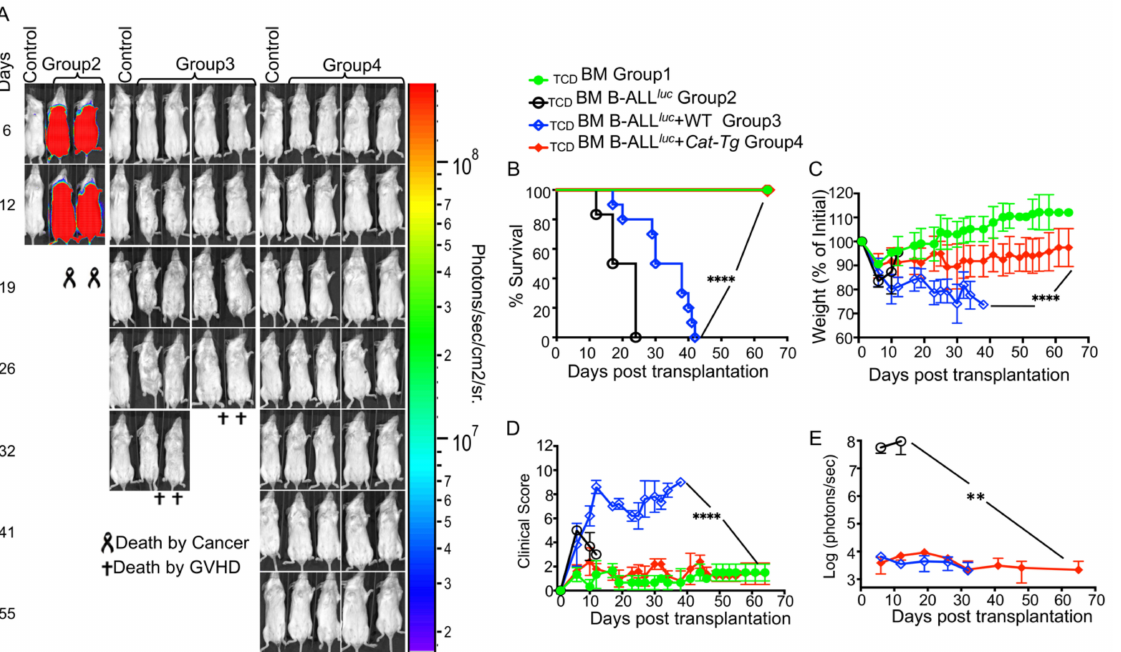
Figure 1. Wnt/ β -catenin overexpression in T cells results in retention of GVL effect but avoids GVHD during allo-HSCT. 1 10 6 purified WT or Cat-Tg CD3+ T cells were transplanted into lethally irradiated BALB/c recipient mice, along with × 1 10 7 T cell-depleted bone marrow cells from WT mice and 1 10 5 B-ALL- luc cells. Host BALB/c mice were imaged using × × the IVIS50 system 3 times a week. Group 1 received T cell-depleted bone marrow only (labeled as TCD BM). Group 2 received 1 10 7 TCD BM from WT mice and 1 10 5 B-ALL- luc cells ( TCD BM+B-ALL luc + ). Group 3 was transplanted with 1 10 7 × × × 6 purified WT CD3 + T cells, along with 1 10 5 B-ALL luc + cells ( TCD BM+B-ALL luc + WT). TCD BM from WT mice and 1 × 10 × Group 4 received 1 10 7 TCD BM from WT mice and 1 10 6 purified Cat-Tg CD3 + T cells, along with 1 10 5 B-ALL- luc + × × × cells ( TCD BM+B-ALL luc + Cat-Tg ). ( A ) Recipient BALB/c mice were imaged using IVIS50 3 times a week. The mice were also monitored for ( B ) survival, ( C ) changes in body weight, and ( D ) clinical score for 65 days post BMT. ( E ) Quantitated luciferase bioluminescence of tumor growth. Statistical analysis for survival and clinical score was performed using log-rank test and one-way ANOVA, respectively. For weight changes and clinical score, one representative of two independent experiments is shown ( n = 3 mice/group for BM alone; n = 5 experimental mice/group for all three other groups) Survival is a combination of two experiments. Note: Control mouse is a naïve mouse used as a negative control for BLI. ** p 0.01; **** p ≤ ≤